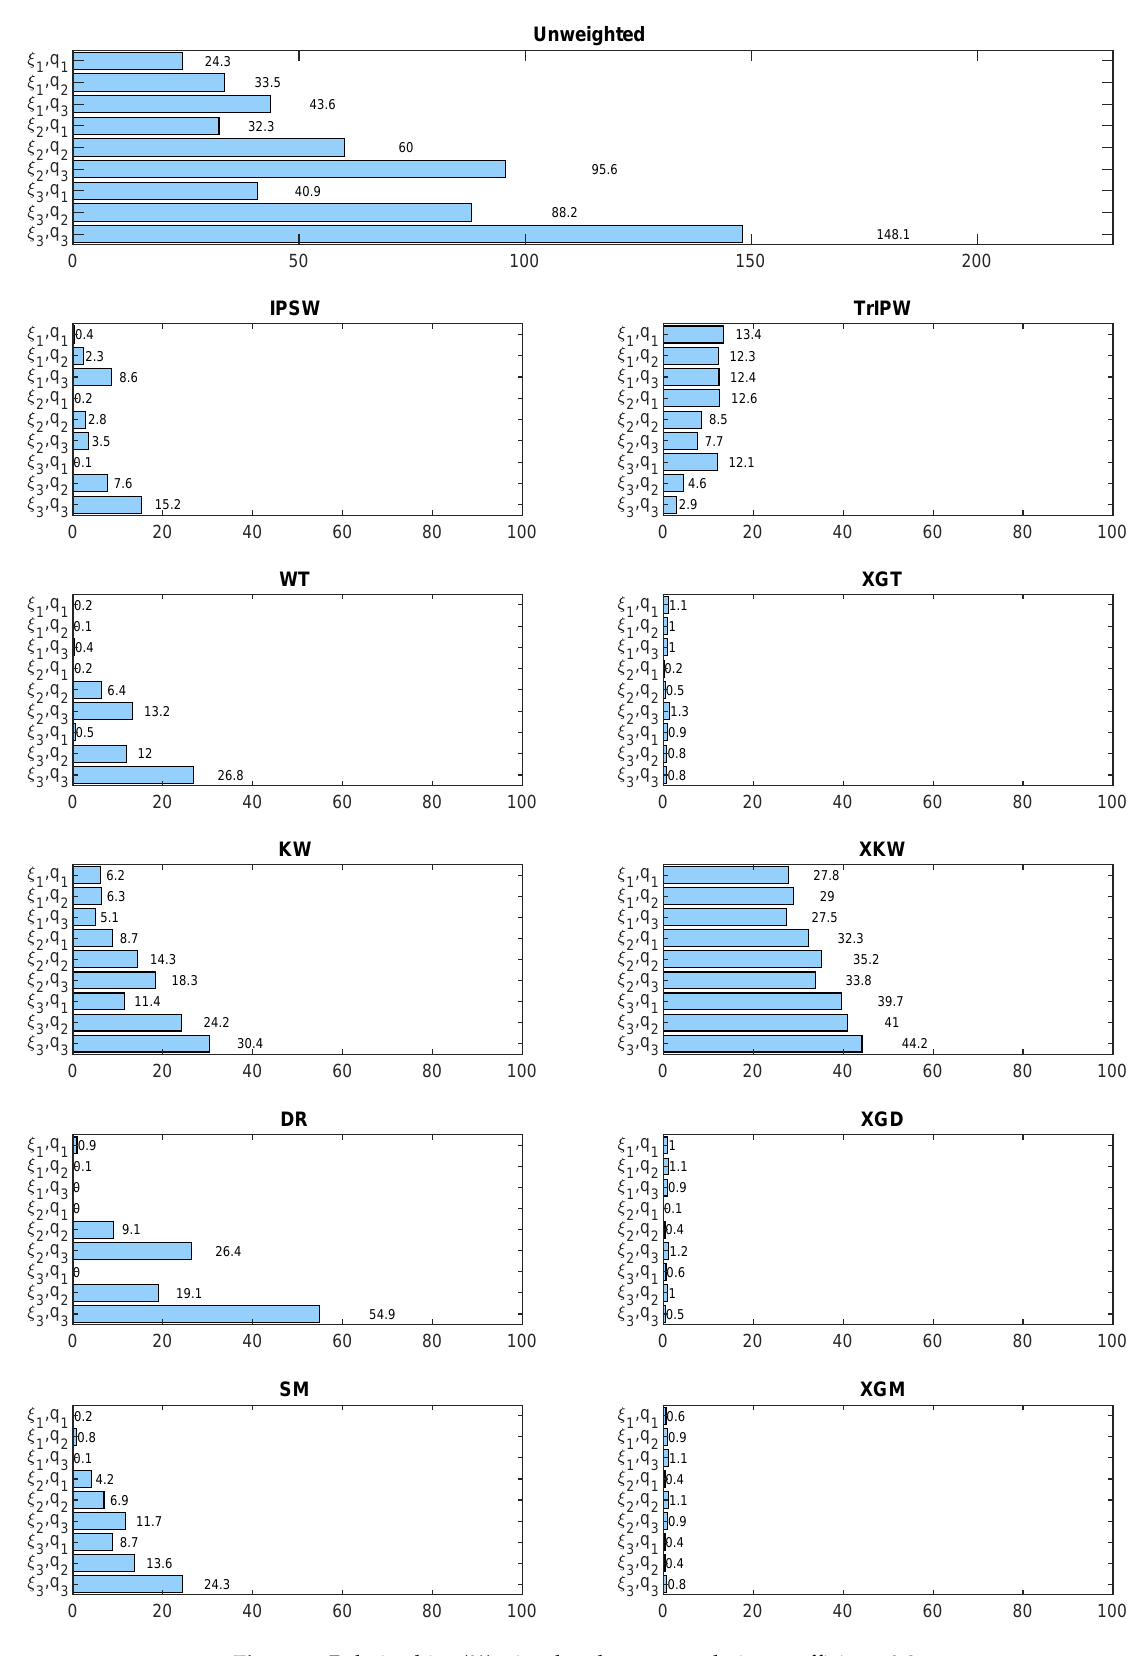
Figure 4. Relative bias (%), simulated case, correlation coefficient: